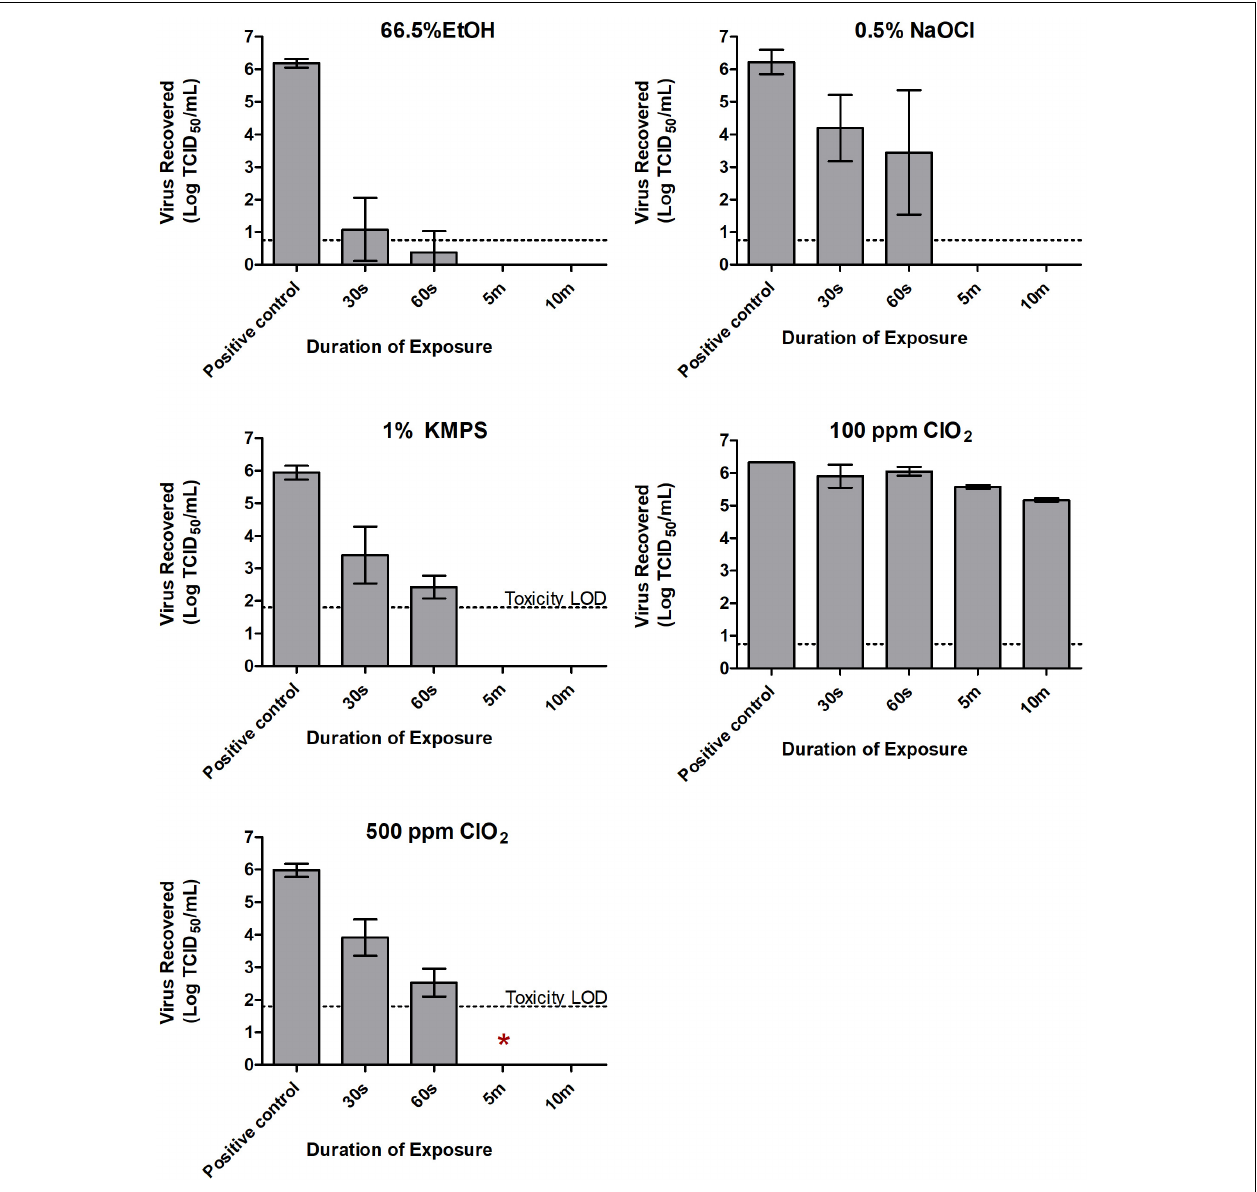
FIGURE 1 | Inactivation of SARS-CoV-2 with 66.5% ethanol (EtOH), 0.5% sodium hypochlorite (NaOCl), 1% potassium monopersulfate (KMPS), 100 ppm chlorine dioxide (ClO 2 ), and 500 ppm ClO 2 during the quantitative carrier test 2 (QCT-2 assay). Inoculated carriers were subjected to various durations of exposure with each of the examined disinfectants. All carriers were neutralized in a pre-determined neutralizer following indicated exposure times, with subsequent viability testing in Vero E6 cells. Dashed lines indicate limits of quantification using the TCID 50 assay. Toxicity LOD (i.e., limit of detection) reflects residual cytotoxicity in neat dilutions from neutralized carriers. Results represent the means of three independent experiments including three biological replicates each. Symbol *Indicates presence of viable virus in safety testing of a single biological replicate from the indicated treatment